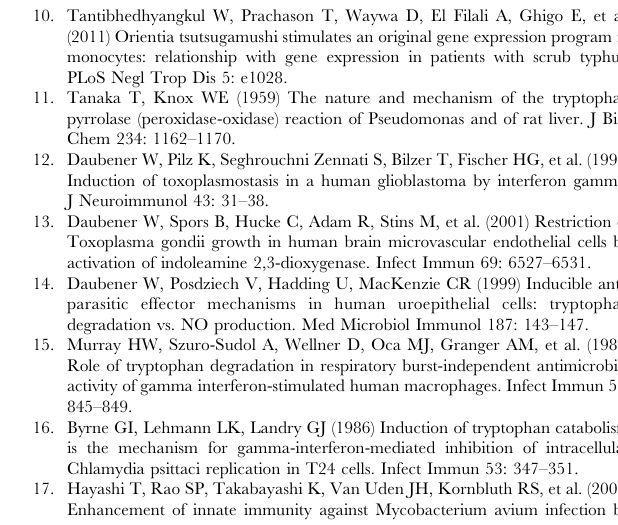
Figure S1 A relationship between serum L-Kyn and AST in patients with scrub typhus (n= 16). r = Spearman’s rho. Table S1 Sequences of primer pairs for qPCR. Table S2 Association between characteristics of the patients and levels of serum L-Trp, serum L-Kyn, and L-Kyn/L-Trp ratio. Table S3 Levels of serum L-Trp, serum L-Kyn, and L- Kyn/L-Trp ratio in patients with scrub typhus classified by clinical